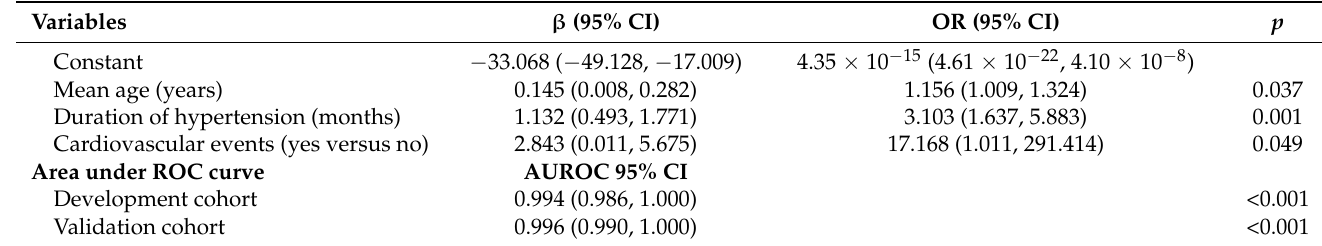
Table 3. Multivariate binary logistic regression of patients in development cohort.